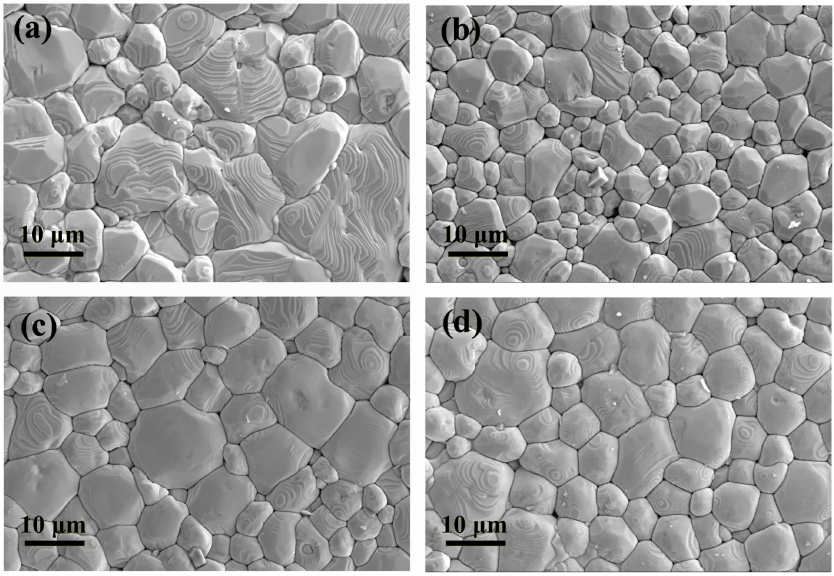
Figure 2. SEM micrographs of the BZT-0.5BCT- x Pr 3+ ceramics: ( a ) x = 0; ( b ) x = 0.1; ( c ) x = 0.2; ( d ) x =